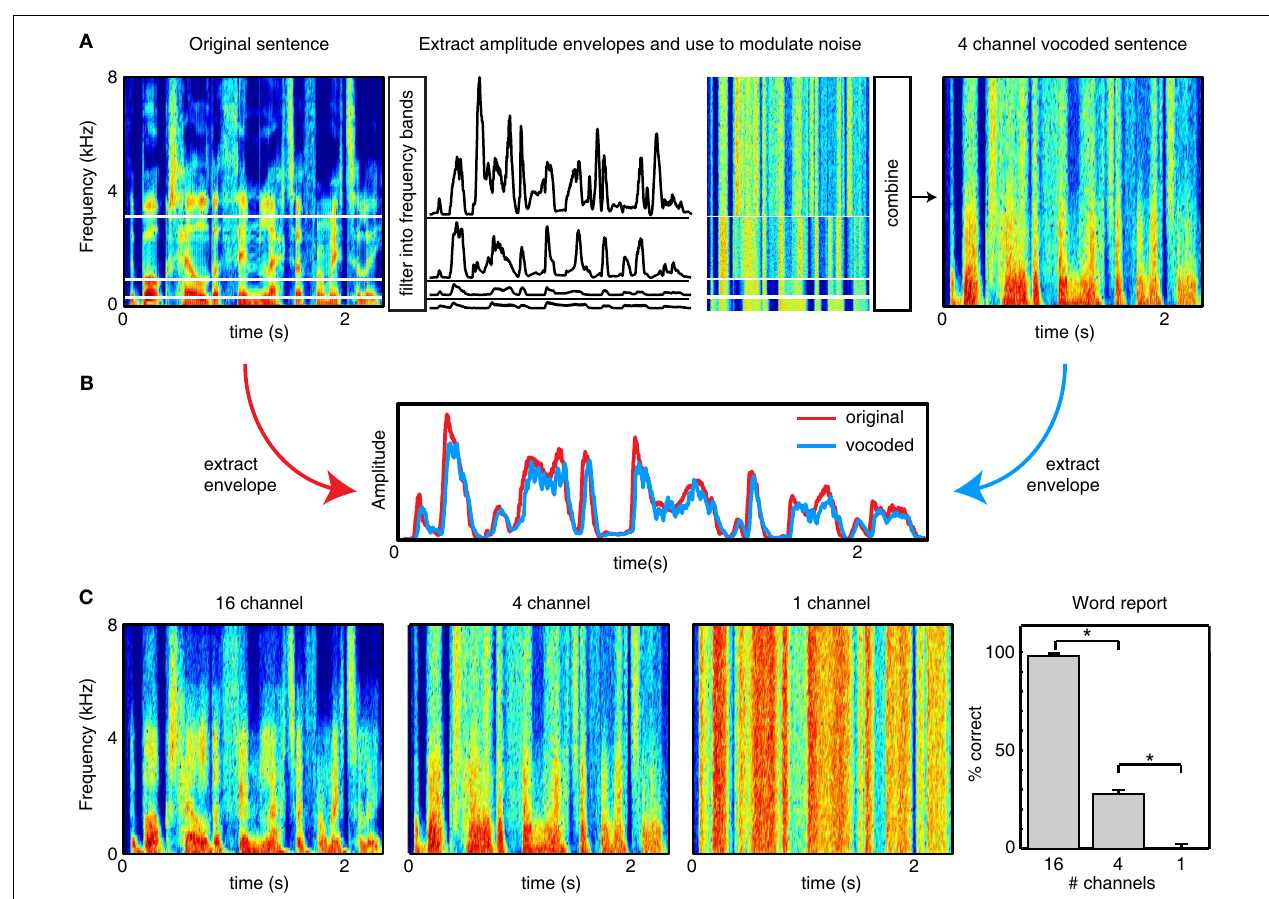
stimulus that has significantly reduced spectral detail compared to the original speech.The more channels included in the vocoder, the more spectral detail results leading to more intelligible speech. (B) The overall amplitude envelope of a clear and vocoded sentence are nearly identical. Thus, although vocoded speech can differ markedly in intelligibility from clear speech, it retains the low-frequency amplitude modulations critical for perceiving speech rhythm. (C) Examples of the same sentence vocoded with 16 channels, 4 channels, or 1 channel. Fewer channels result in less spectral detail, as well as lower intelligibility (word report data from Peelle et al., in